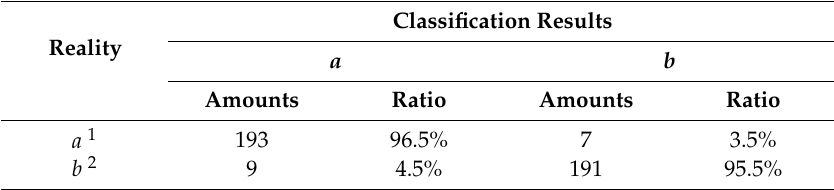
Table 1. The confusion matrix of Formula (5) classification results.